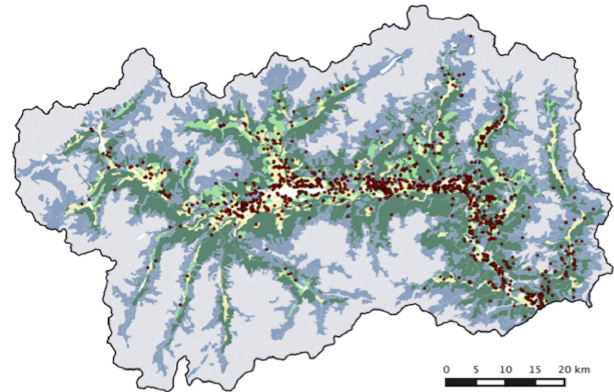
Figure 2. Fire ignitions in years 1995–2009 (red dots) and Corine Land Cover (year 1990) vegetation types in the study area (yellow: agricultural areas; light green: permanent meadows; dark green: forests; blue: pastures and shrubs; grey: unvegetated; white: